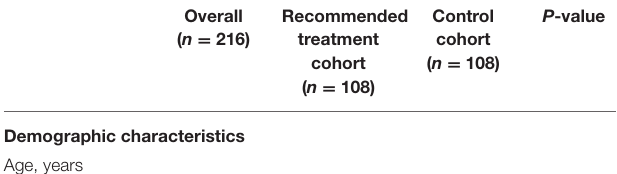
TABLE 1 | Demographics and early symptoms associated with COVID-19 illness in the two treatment